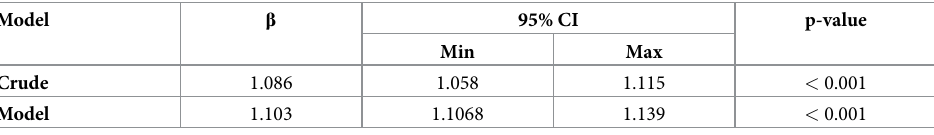
Table 4. Logistic regression analysis of the effect of the various variable son CTRP15.